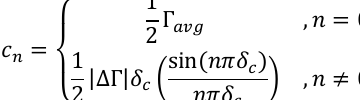
Figure 3. Measured spectrogram with the backscatter enabled and disabled for SF = 12, BW = 125 kHz.